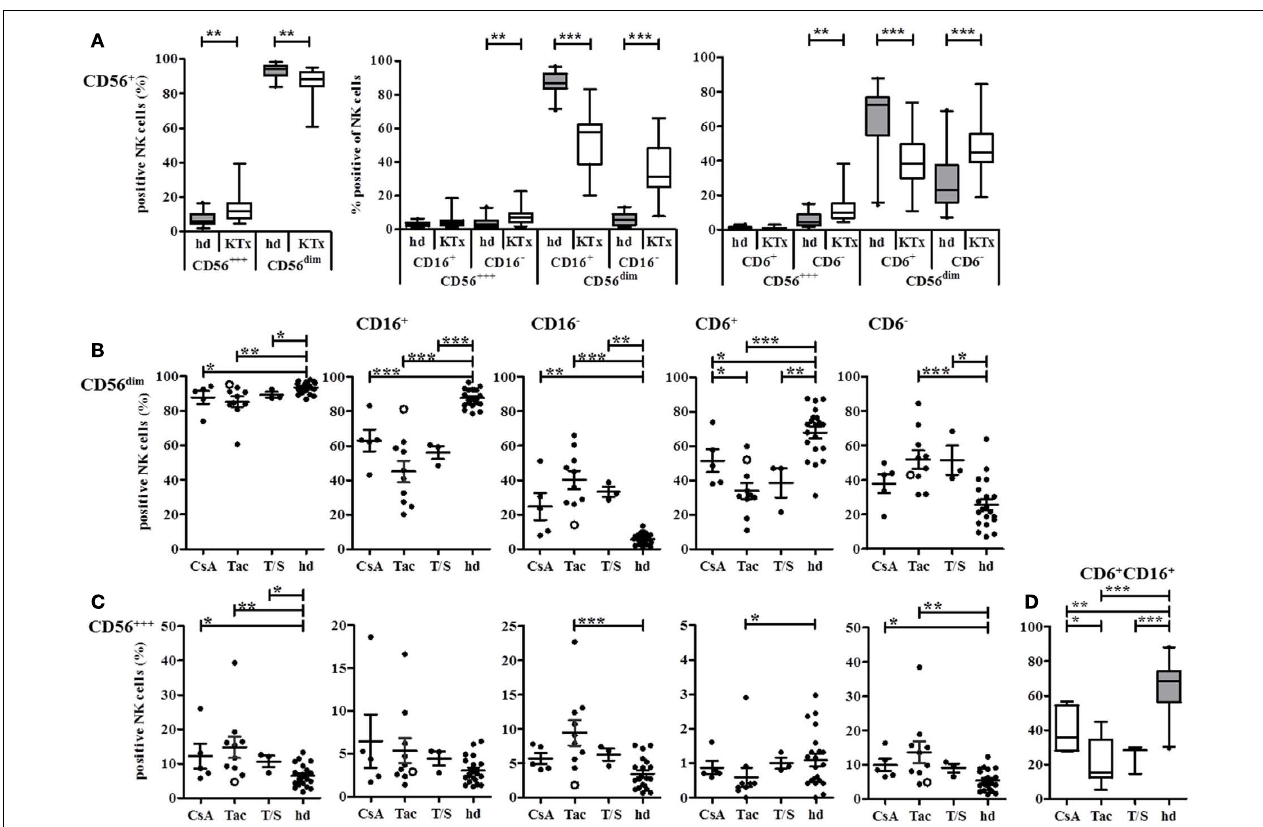
and CD16 − or CD6 + and CD6 − CD56 bright NK cells and each subset was compared between patients and healthy individuals. KTx-patients were further classified into three groups regarding their immunosuppressive regimen: CsA,Tac, and combination ofTac + Sir (T/S). One patient was initially treated with CsA for 5months after KTx and then switched to Tac for the following 7months [ (B,C) , open circle]. (D) CD6/CD16 double-positive NK cells are calculated for each treatment group and healthy individuals.The combined expression of the different markers is given as percentages of all CD3 − CD56 + NK cells. Each data point indicates one donor, and median values with standard deviations are depicted as black